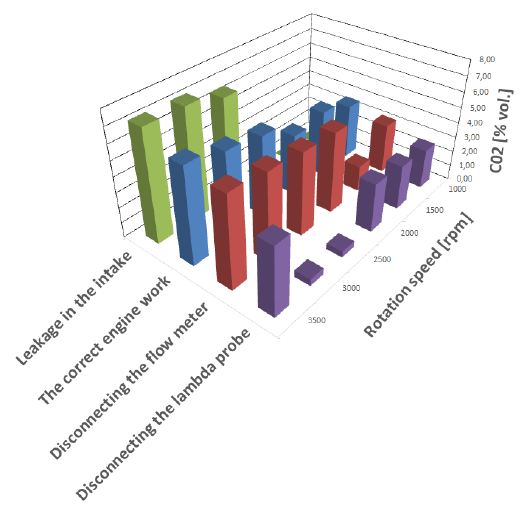
Fig. 8. The carbon dioxide content in the exhaust gas of a BMW engine fueled with LPG working efficiently and for simulated damage